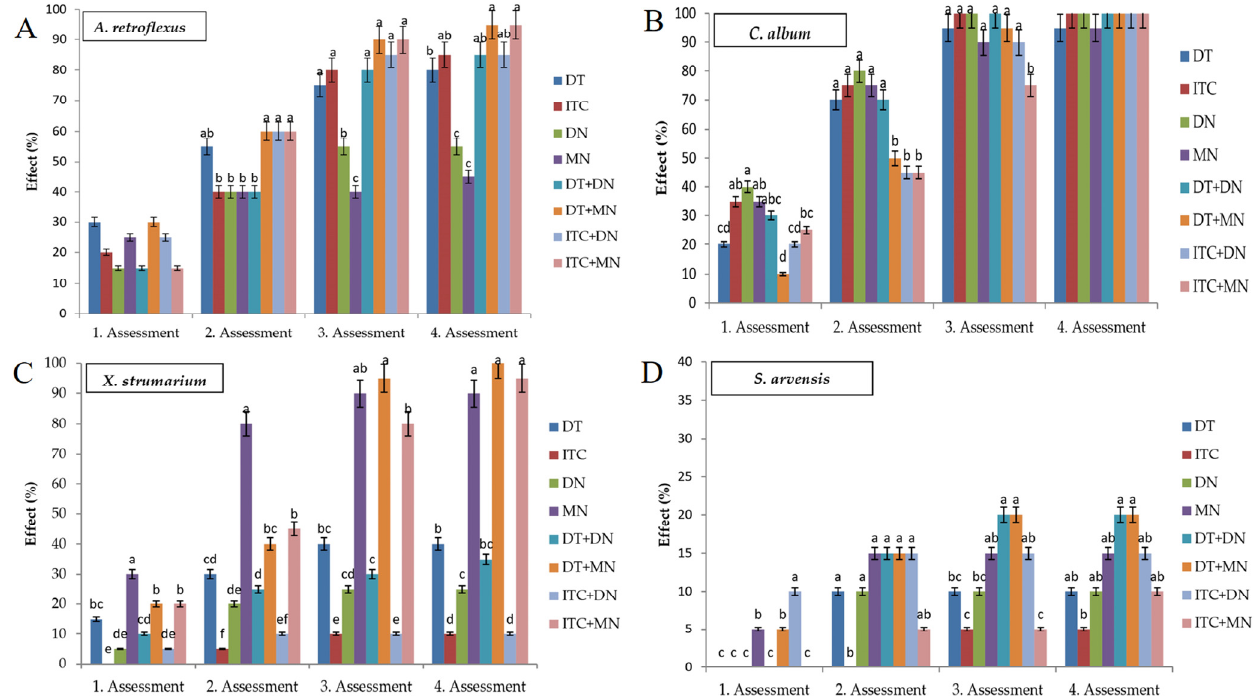
Figure 4. Effects of herbicides on ( A ) A. retroflexus , ( B ) C. album , ( C ) X. strumarium , and ( D ) S. arvensis at different intervals. The differences between the means with the same letter are not significant at the 0.05 level.